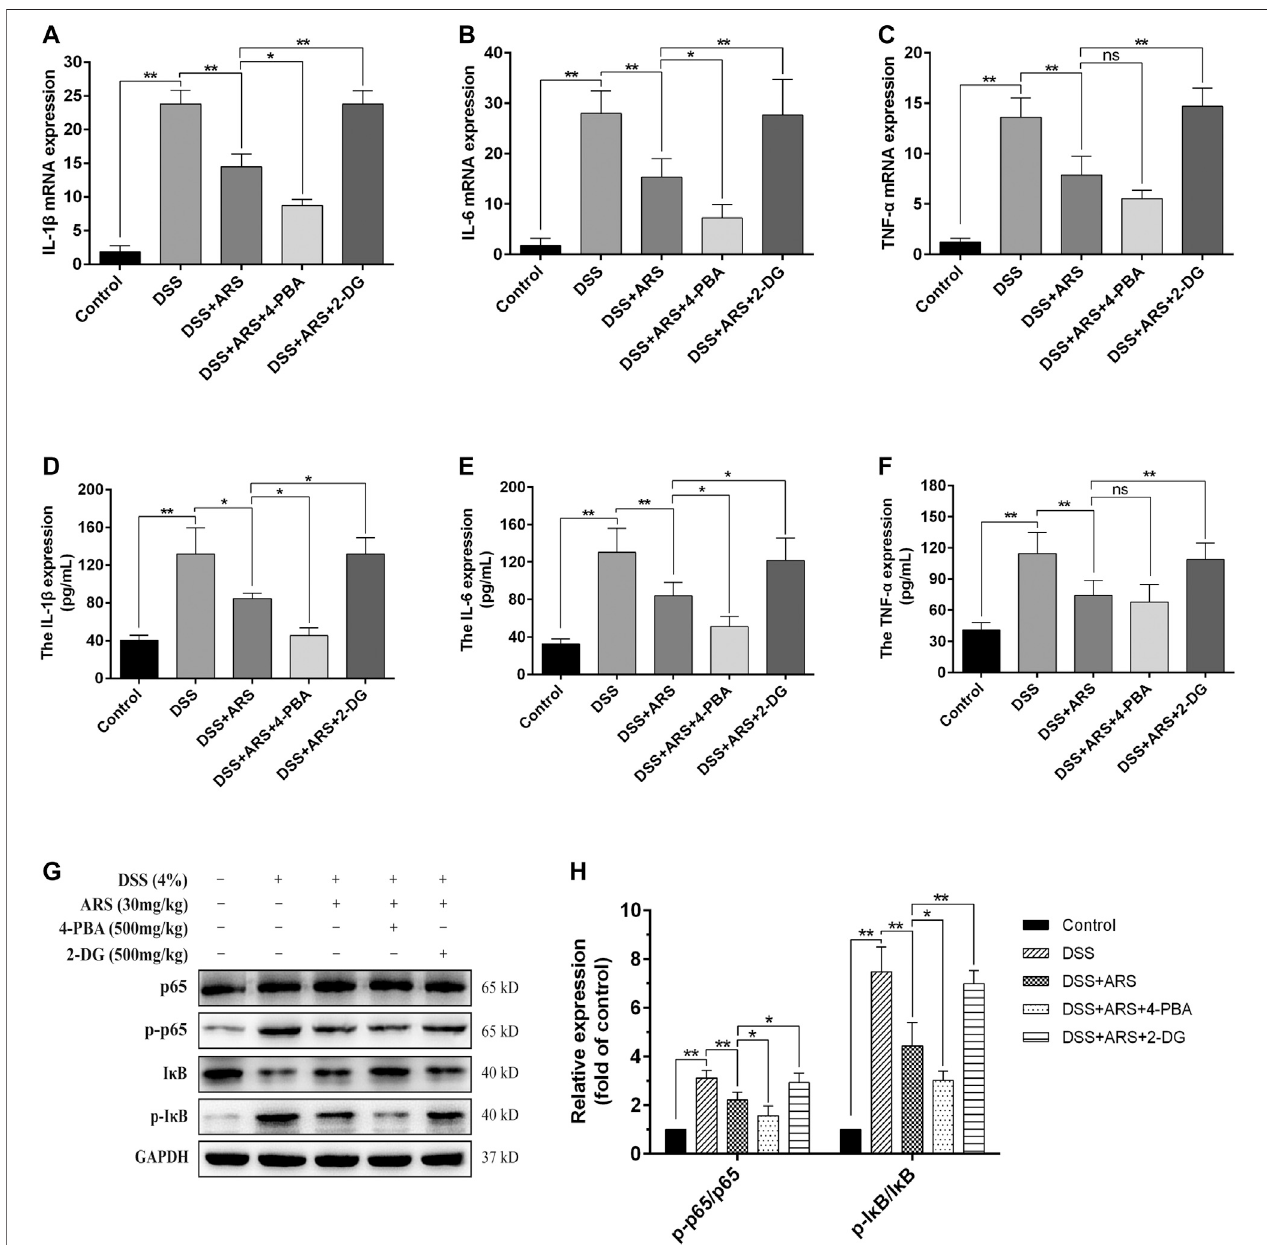
FIGURE 6 | ER stress inhibition involves in the anti-in fl ammatory effect of ARS on DSS-induced colitis. 4-PBA and 2-DG were respectively used as ER stress inhibitorandinducertodemonstratetheroleofERstressontheanti-in fl ammatoryeffectofARS. (A – C) ThemRNAexpressions ofcytokinesIL-1 β ,IL-6,andTNF- α were detected by RT-qPCR. (D – F) The protein expressions of cytokines IL-1 β , IL-6, and TNF- α were detected by ELISA. (G) Immunoblot analysis of the expression levels of p65/p-p65 and p -I κ B/I κ B ratio. (H) Quanti fi ed results from (G) . All the values were expressed as mean ± SD ( n (cid:1) 3), * p < 0.05, ** p < 0.01.